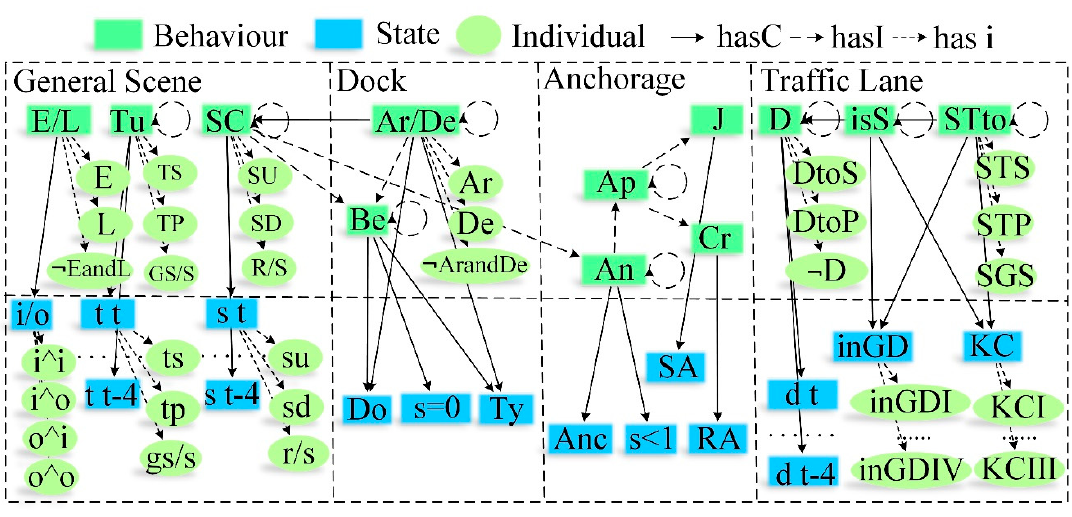
Figure 2. State and Behavior in the semantic network.